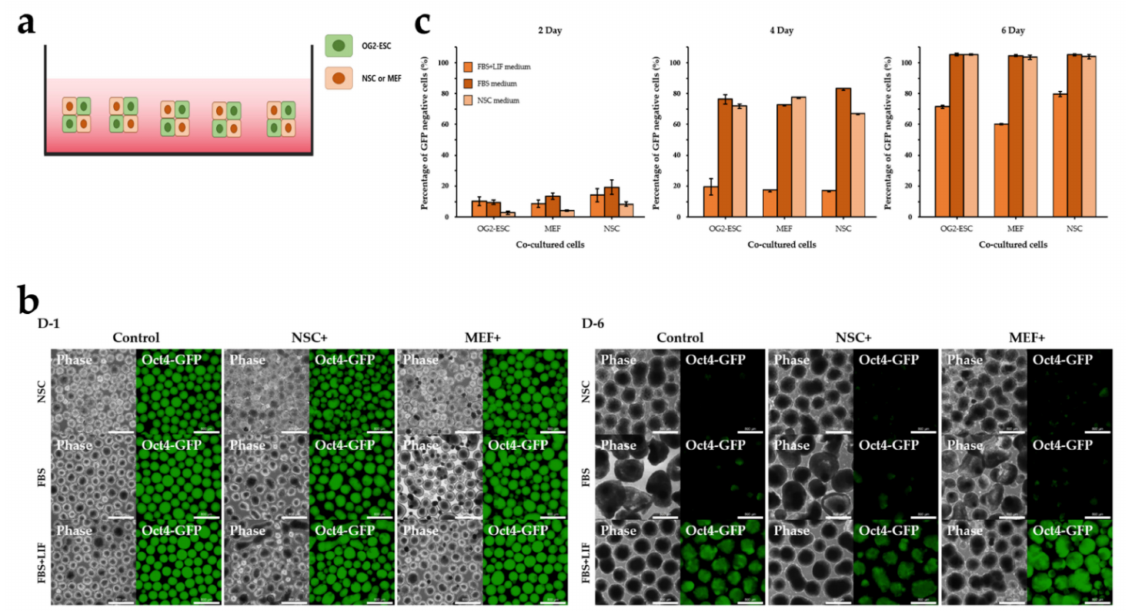
Figure 4. Co-culture of OG2-ESCs with NSC/MEF under 3D condition. ( a ) Embryonic stem cells aggregated with NSCs or MEFs and cultured on suspension dishes. ( b ) Day 1 and day 6 phase and fluorescence (GFP) images of 3D co-cultured OG2-ESCs on suspension dish in FBS, FBS+LIF, and NSC medium for 6 days. Scale bar = 800 µ m. ( c ) Flow cytometry analysis of the percentage of Oct4-GFP-negative cells co-cultured with OG2-ESC, NSC, or MEF in FBS, FBS+LIF, and NSC media for 2, 4, and 6 days. Data are mean ± SE, n = 3 biological replicates.